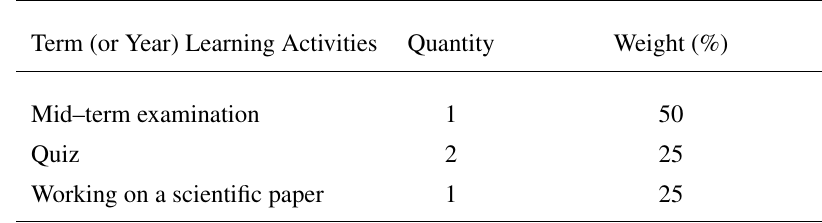
Table 1. The assessment methods and criteria for Astrobiology course.